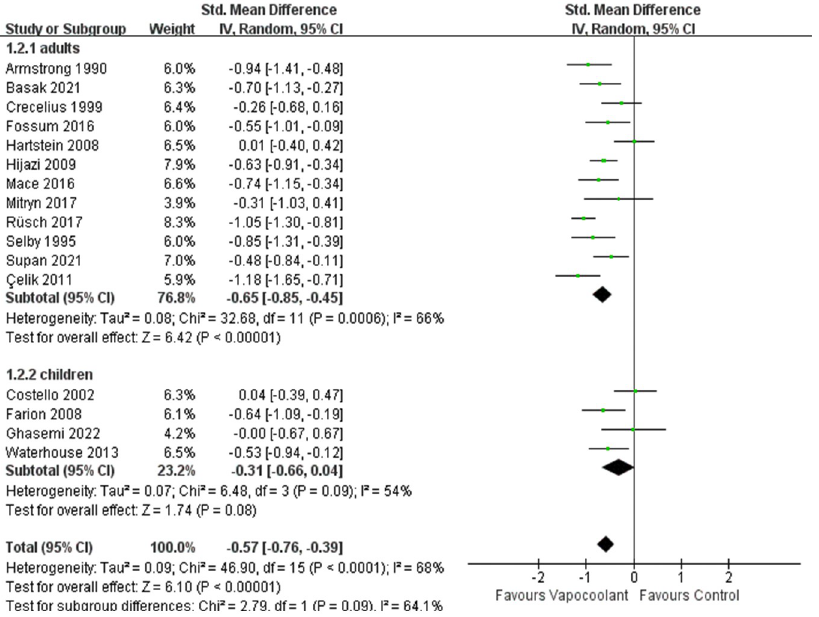
Fig 5. Subgroup analysis of pain scores during intravenous cannulation: Vapocoolants in children vs adults.